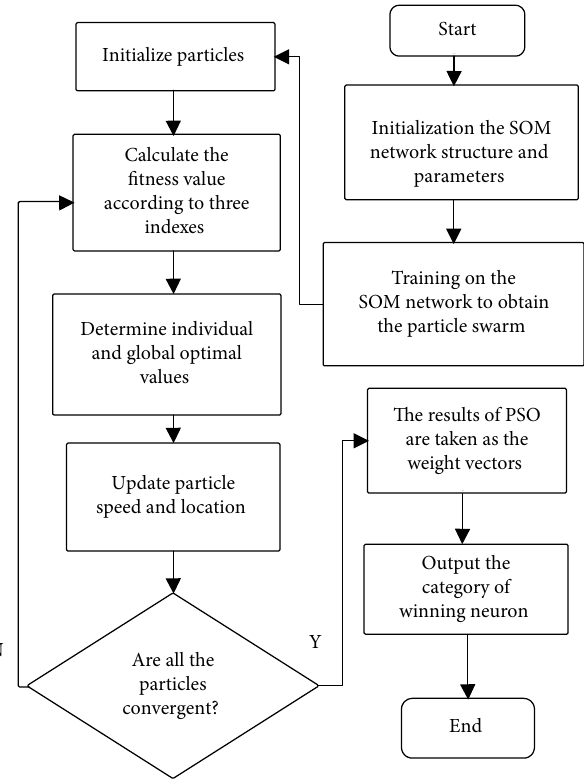
Figure 3: The flow chart of PSO–SOM algorithm.